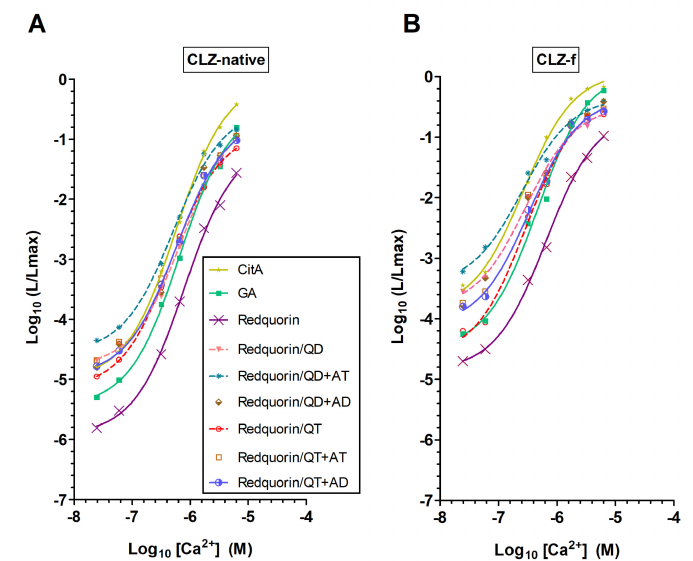
Figure 4. Ca 2 + sensitivity of Redquorin and its mutants relative to GFP-aequorin (GA) and CitA. The relationship between Ca 2 + concentration ([Ca 2 + ]) and fractional bioluminescence intensity (L / Lmax) is displayed in Log values on a linear scale ( n was at least 4). Aequorin moieties of the fusion proteins were reconstituted with native CLZ ( A ) or CLZ-f ( B ). For Redquorin (Rdq), a sigmoidal curve fit is traced for comparison. R square of the fit goodness was higher than 0.994. Table 2. Properties of Redquorin and its mutants relative to GA and CitA. Ca 2 + Decay Kinetics, Mutation Sensitivity, t 1 / 2 (ms) EC50 (nM) a